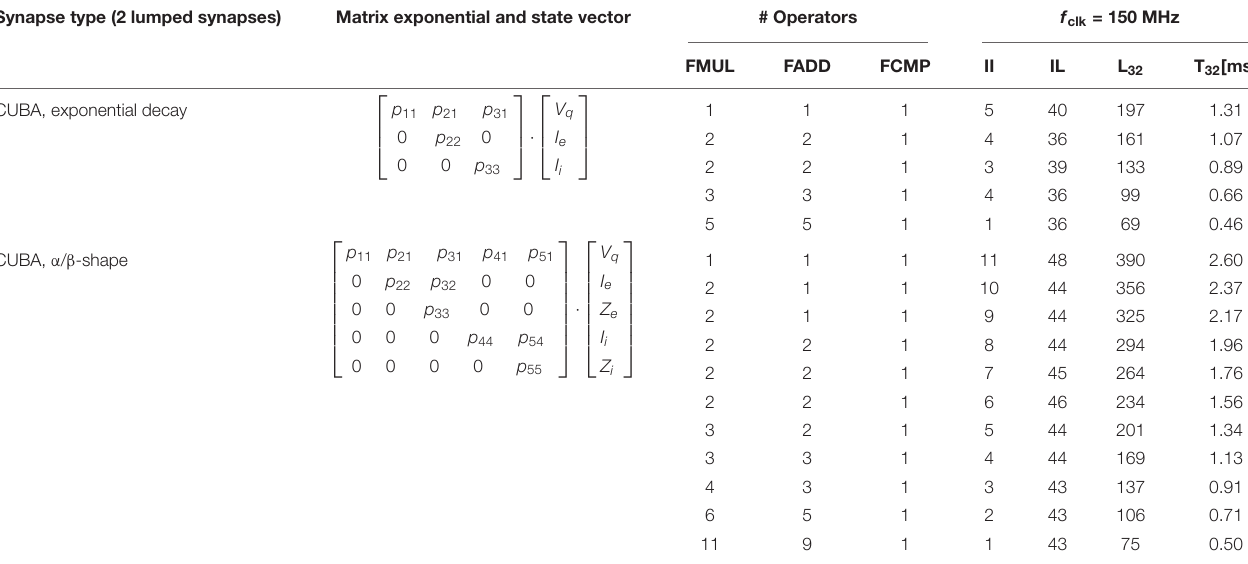
TABLE 1 | Results of a simple design space exploration of the ODE solver for different variants of synaptic shapes and parameterizations assuming a LIF neuron. Synapse type (2 lumped synapses) Matrix exponential and state vector